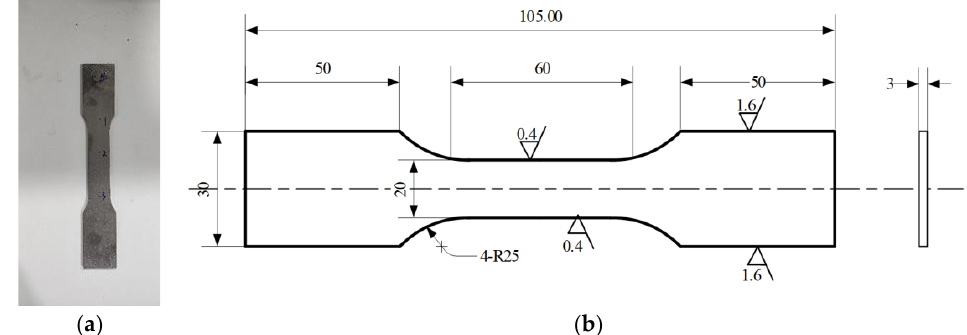
Figure 3. Shape design of specimen, which referred to GB/T 228.1-2010 “Metallic materials—Tensile testing—Part 1: Method of test at room temperature” : ( a ) specimen and ( b ) geometries of the specimen. All dimensions are in mm.